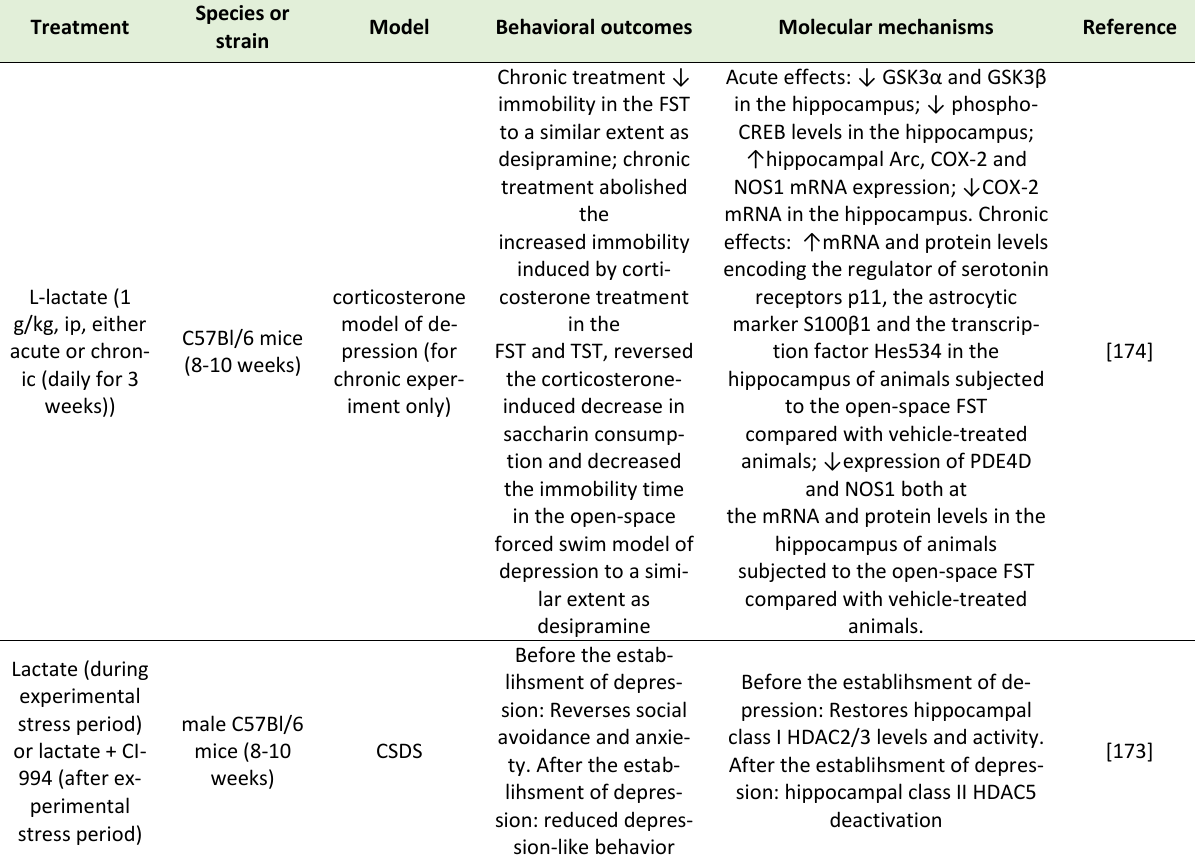
TABLE 5. Studies investigating the effects of lactate on depressive-like behavior.